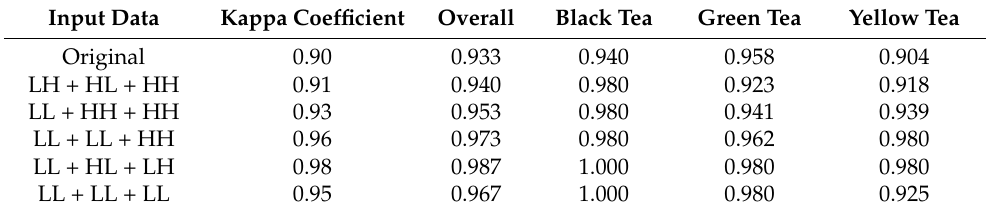
Table 5. The accuracy of tea classification based on the combination of different wavelet components. Input Data Kappa Coefficient Overall Black Tea Green Tea Yellow Tea